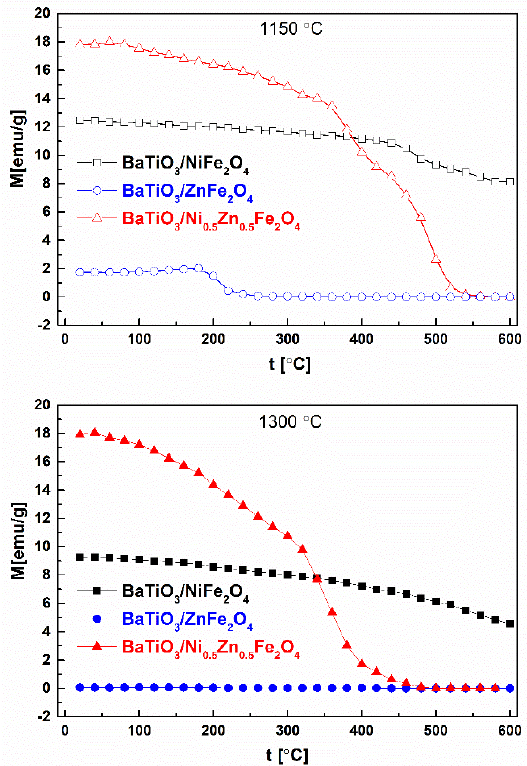
Figure 5. Temperature dependence of mass magnetization in the applied magnetic field of 50 kA/m for all sintered samples.